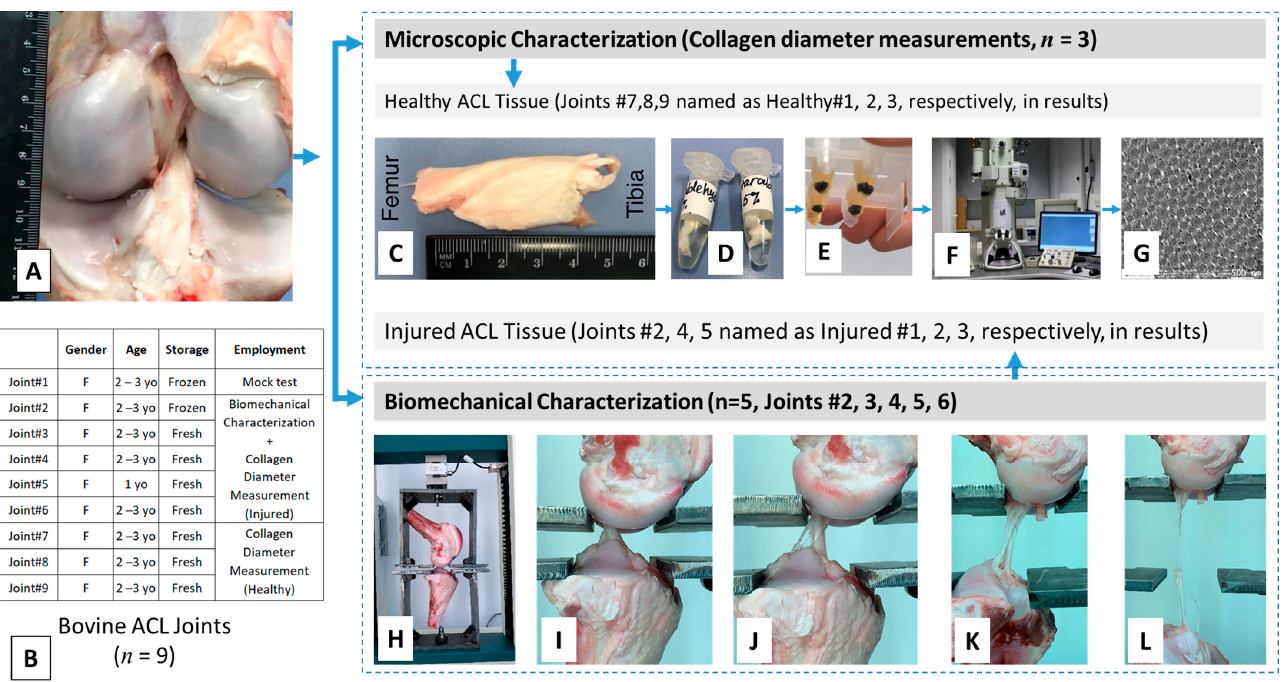
Figure 9. Experimental design of and representative images from native ACL harvesting and characterization. The ACL joint ( A ), demographics and processing of tissues before characterization ( B ), and procedure for transmission electron microscopy (TEM) characterization ( C – G ) and mechanical characterization ( H – L ).